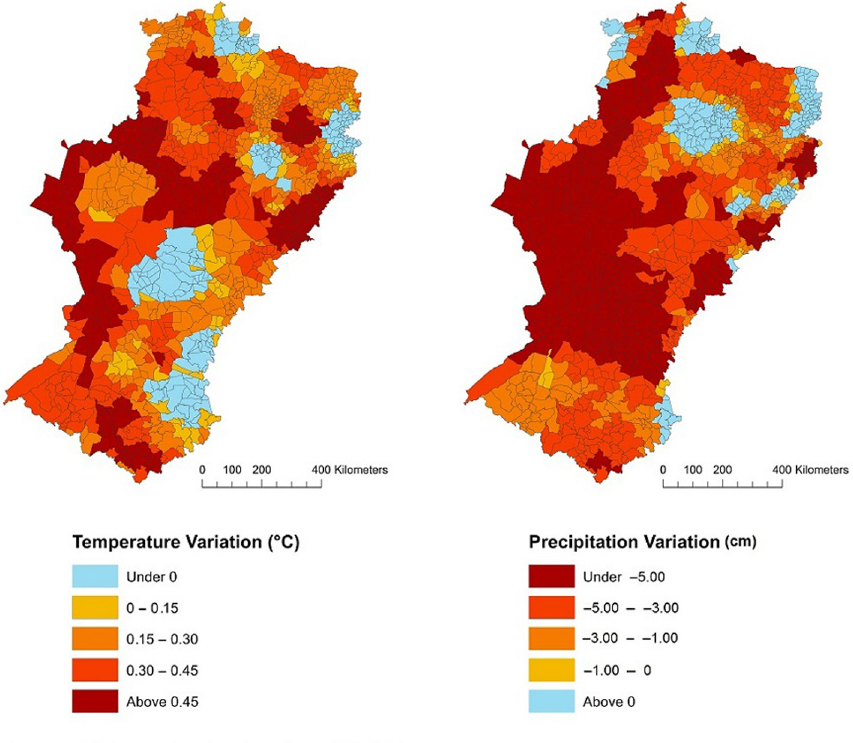
Figure 2. Average variation per decade in temperature and